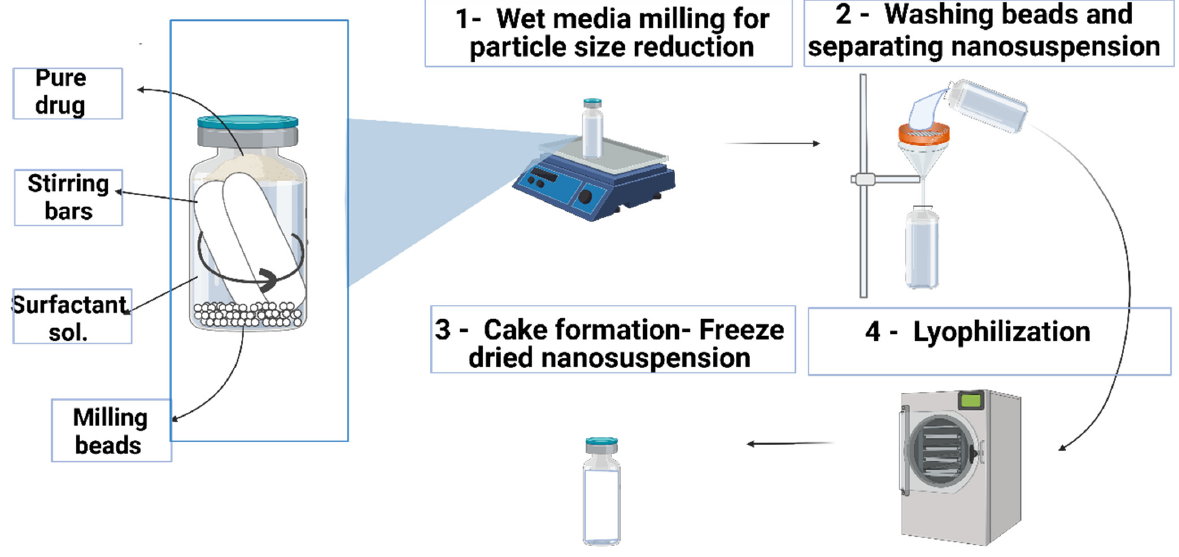
Figure 1. Schematic representation of the fabrication of the DFS ‐ NS.